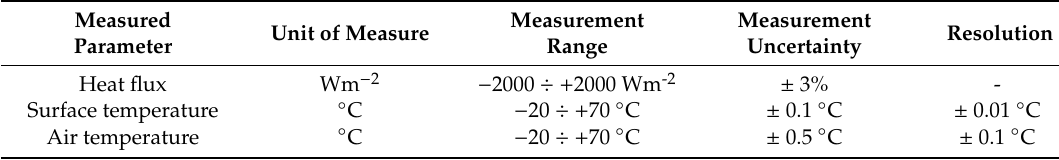
Figure 16. Thermal images of pre-assembled prototype facades. ( a ) East facade; ( b ) upper part of the North facade; ( c ) lower part of the North facade. Table 3. Characteristics of the used